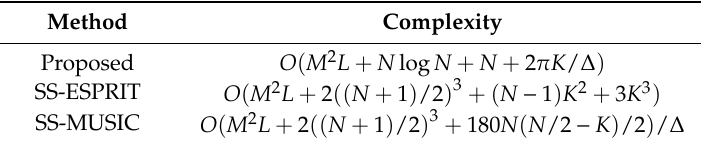
Table 1. Complexity of di ff erent